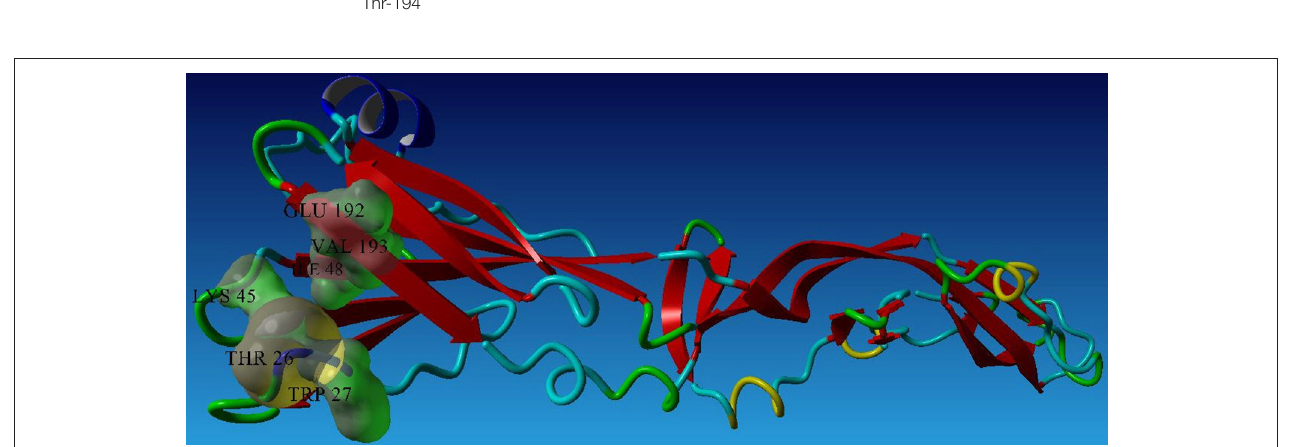
FIGURE 11 | Most common interacting residues of envelope